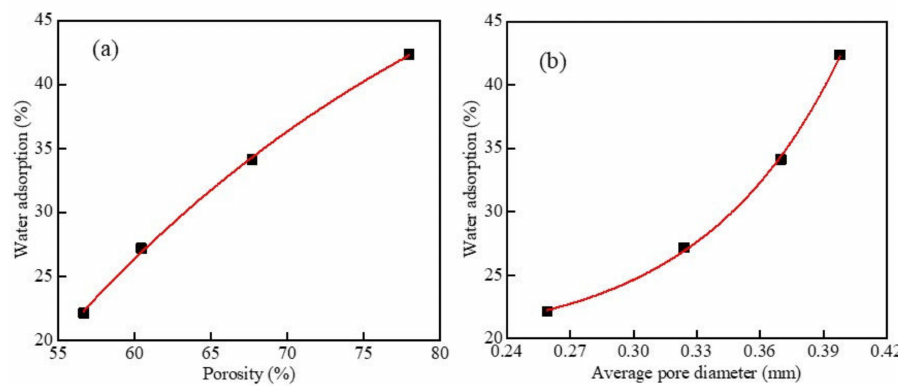
Figure 16. Water absorption versus porosity ( a ) and average pore diameter ( b ) of the recycled foamed concrete containing MSWI powder with different dry